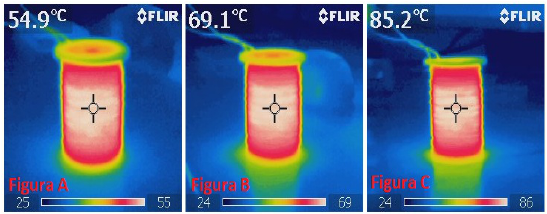
Figure 3. Temperatures of the coil operating at 1.2 A for 25 min, 45 min and 60 min.